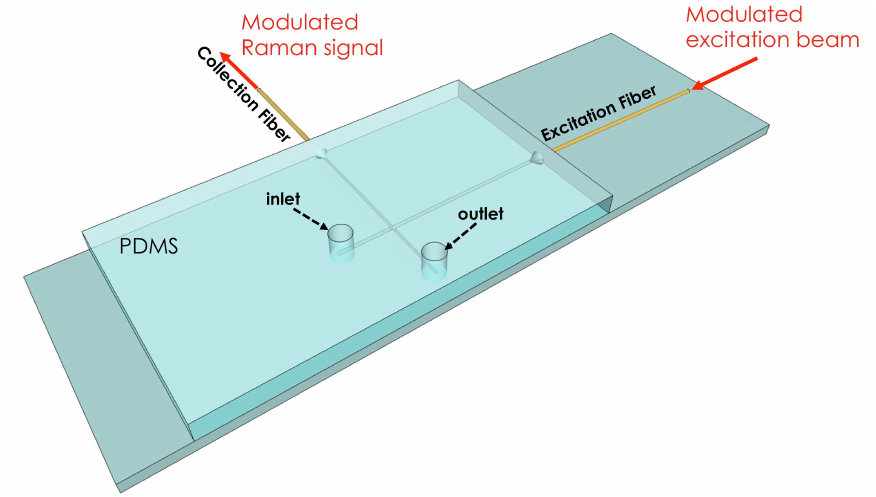
Figure 10. Scheme of the wave guide-confined Raman spectroscopy system [93]: a low OH multimode fibre (Polymicro Technologies, AZ, USA) of a core diameter of 200 µ m delivers the modulated beam into the microfluidic chip for excitation; another fibre of the same specification was used to collect the Raman signal from the microfluidic channel and couple it into the